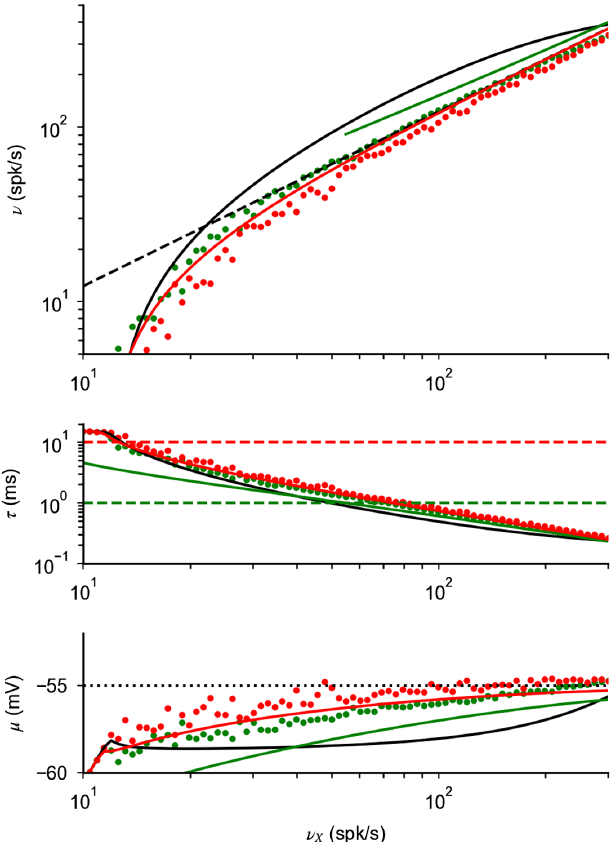
on the pre- E as a function of ν , with X X . Parameters are X